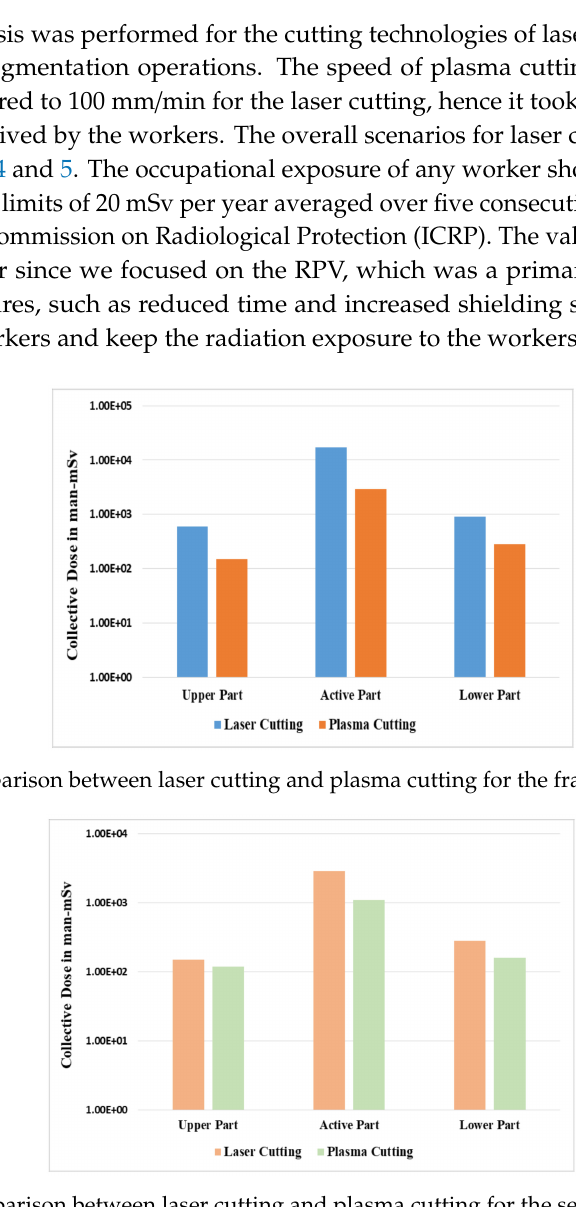
Figure 5. Comparison between laser cutting and plasma cutting for the segmentation